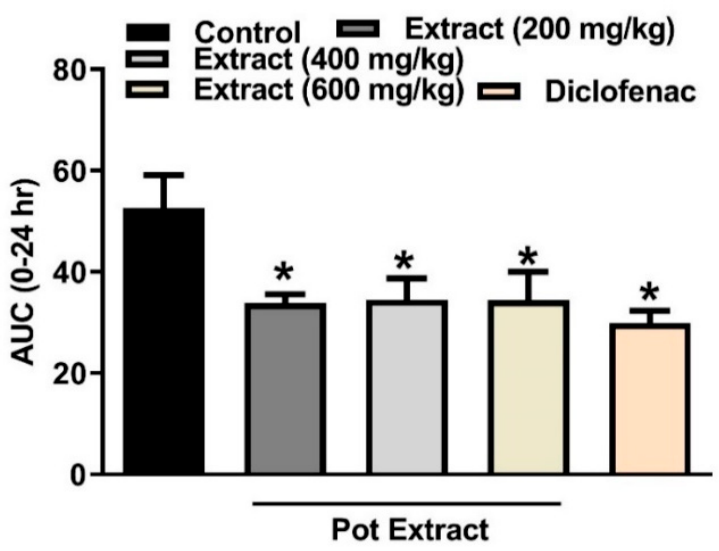
Figure 2. Results from P. perfoliatus extract (200, 400 and 600 mg/kg, p.o.) on carrageenan-induced paw edema in rats. The extract was administered 1 h prior to the carrageenan (1% suspension, 0.1 mL/rat) injection. Edema thickness (mm) was measured at one hour intervals for 5 h and at 24 h vs. control after carrageenan injection. The AUC 0–24 results were expressed as mean ± S.E.M ( n = 5). * p < 0.05 vs. control values.